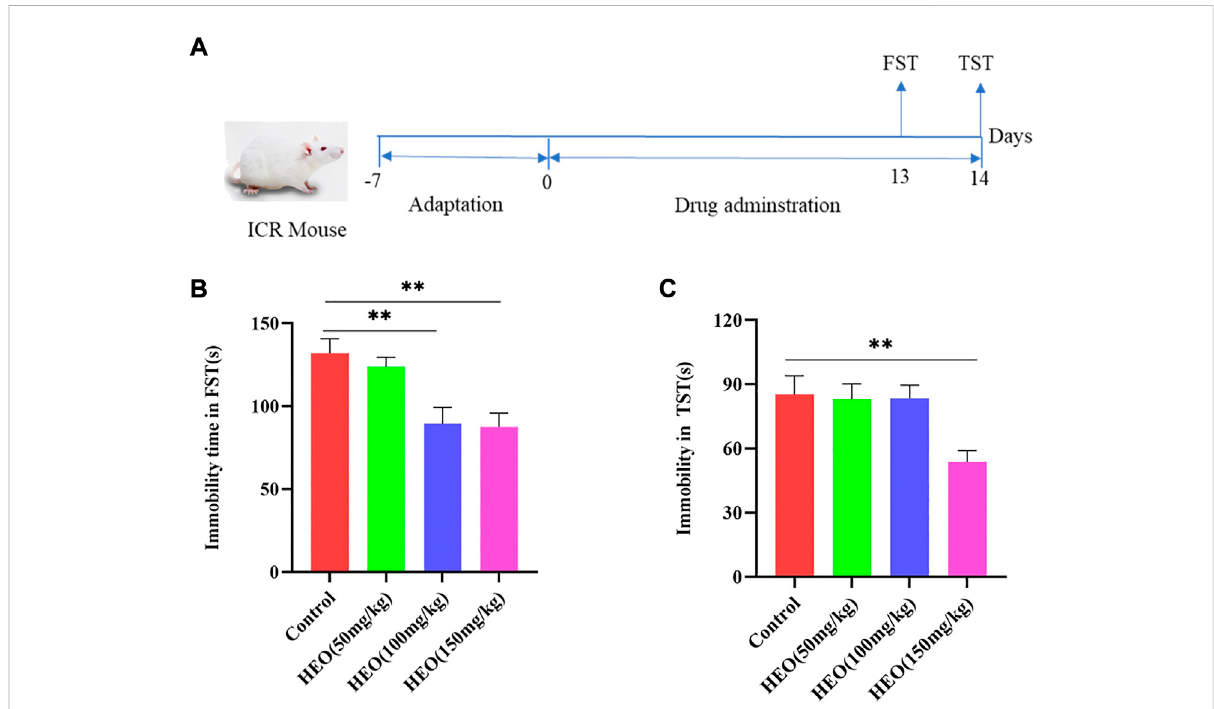
FIGURE 2 HEO treatment decreased the immobility times in FST and TST. The experimental schematic diagram (A) ; immobility time in FST (B) and immobility time in TST (C) . Data were expressed as the mean ± SEM ( n = 8). ** p < 0.01 compared with the control group. HEO, the essential oil from the fruits of Z. bungeanum Maxim.; FST, forced swimming test; TST, tail suspension